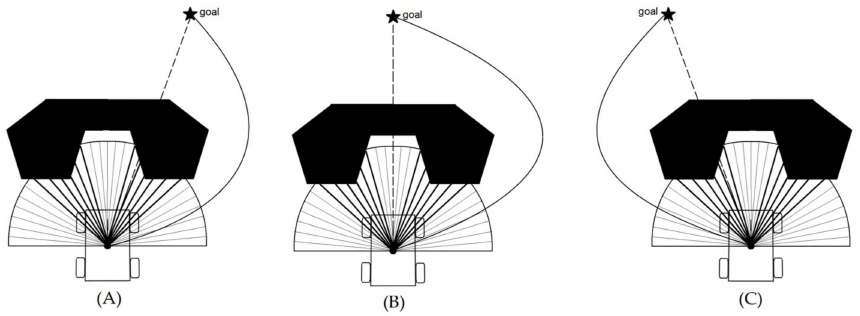
Figure 6. Three cases of nonexistence of FST, with the goal being either slightly to the right of the current course ( A ), straight ahead ( B ), or slightly to the left of the current course ( C